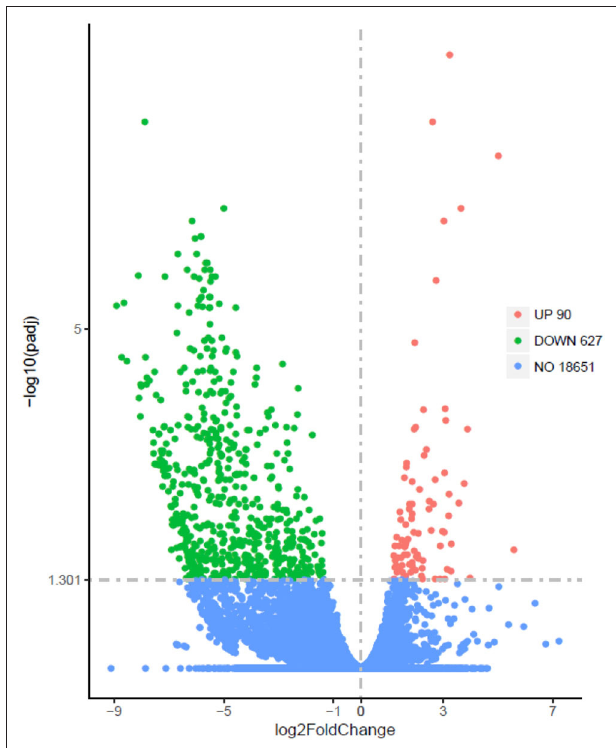
FIGURE 2 | Differentially expressed genes (padj < 0.05, llog2FoldChangl > O) between LD of fattening yaks and grazing yaks. Red denotes significantly up-regulated and green denotes down-regulated